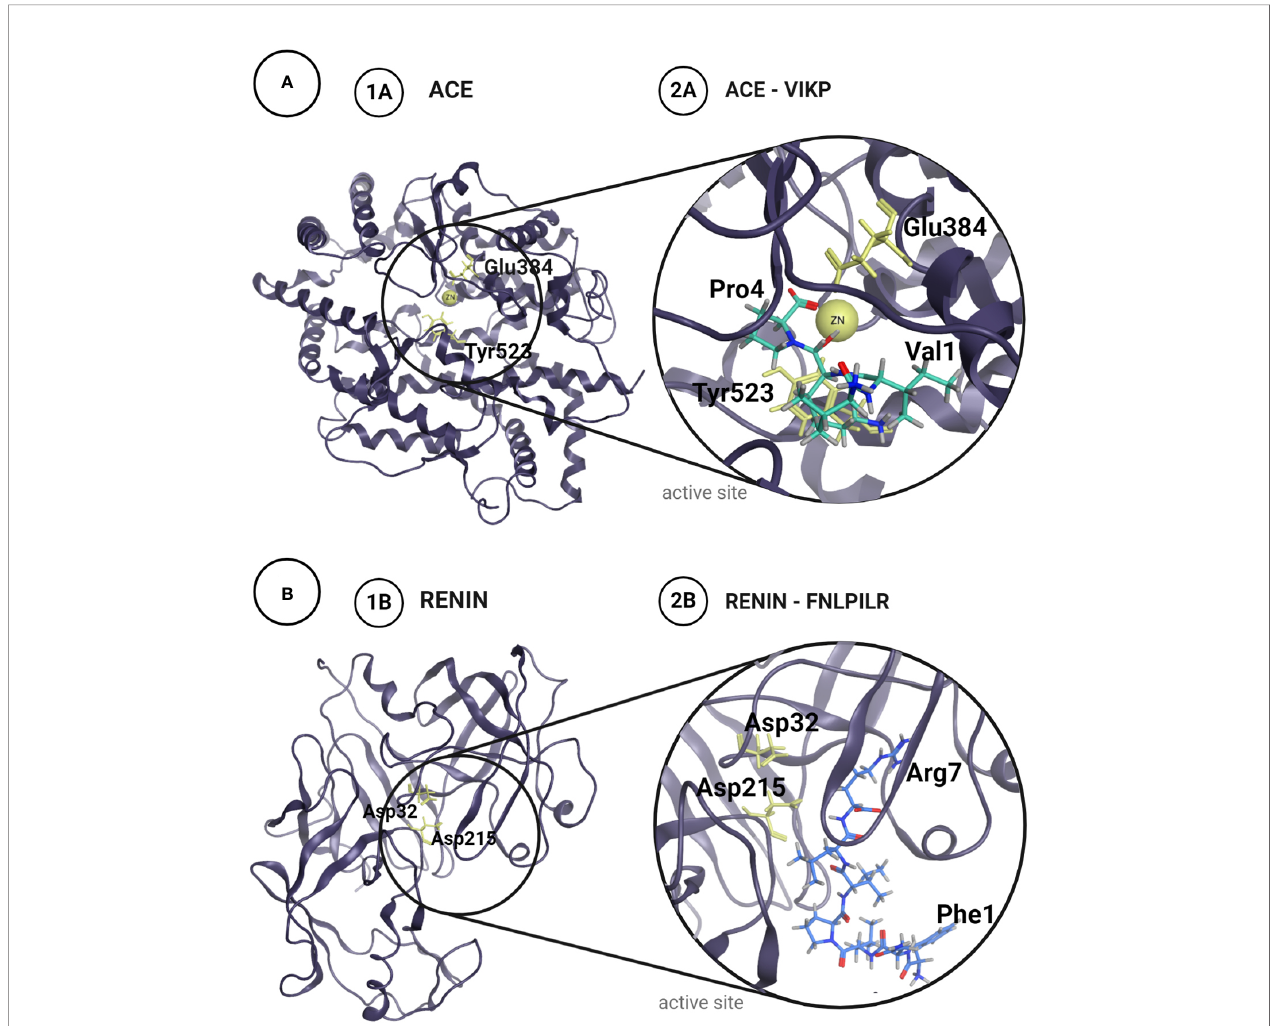
FIGURE 2 | Structures of Angiotensin Converting Enzyme, ACE (A) and Renin (B) with their catalytic residues marked in yellow (1A, B). Proposed complex for the most potent inhibitor peptides identi fi ed in amaranth proteins for each enzyme (2A,